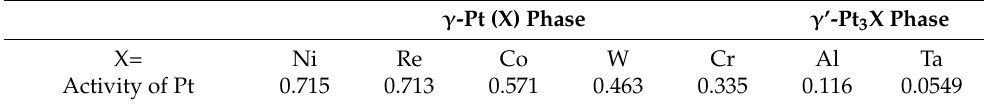
Table 2. The activity of Pt when ∆ C(Pt) γ - γ ’ = 0 at 1150 ◦